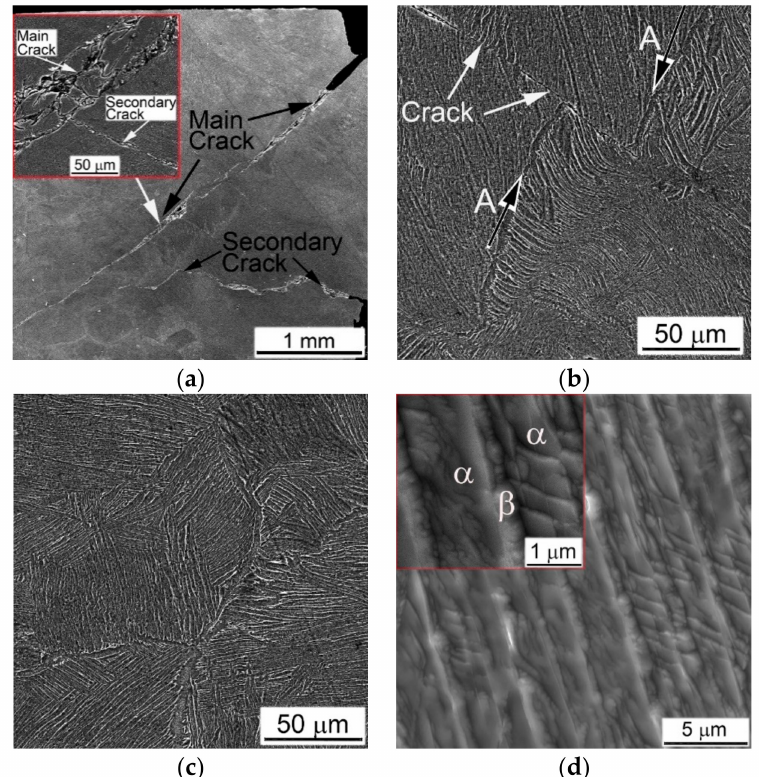
Figure 16. Microstructure of the Ti64LM specimen after the quasi-static test at the strain rate of 0.001 s − 1 : ( a ) general view with zones I and II, ( b )—zone III, ( c , d )—zone IV. SEM,